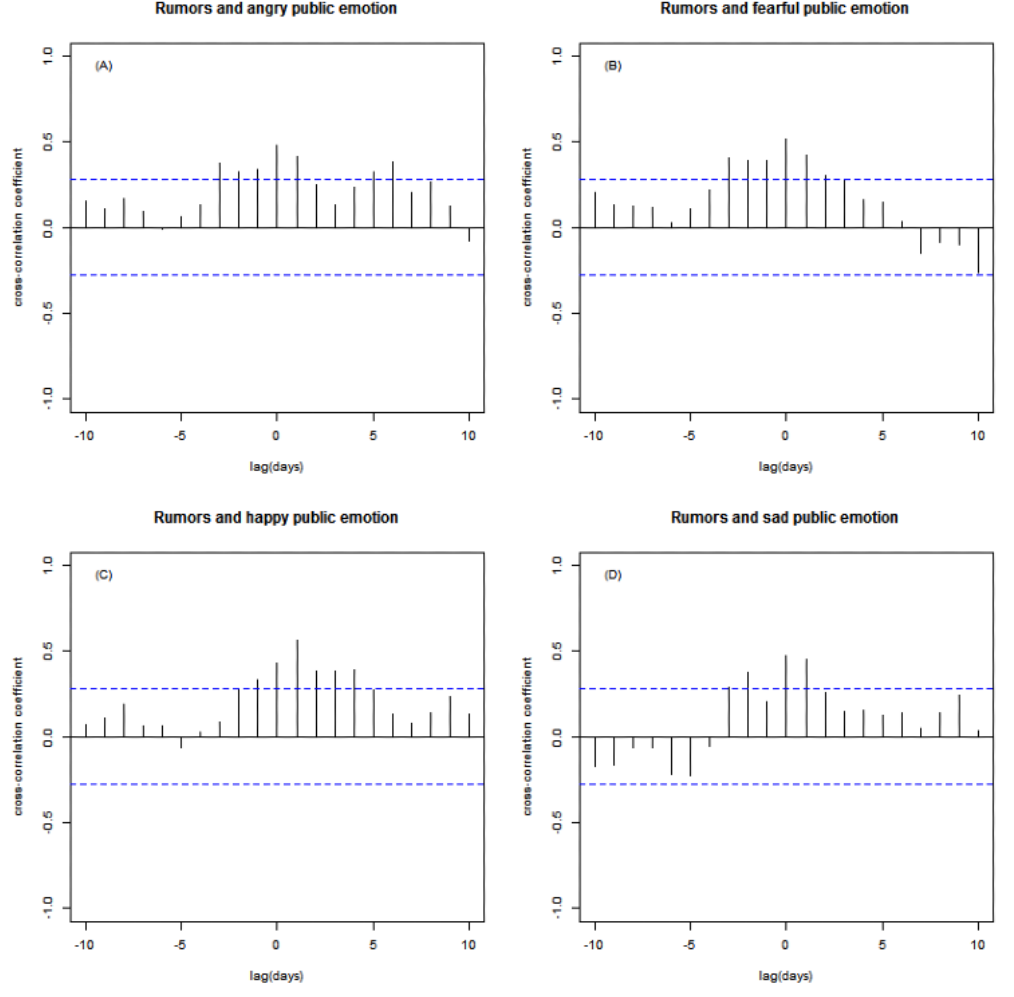
Figure 4. Cross-correlation between emotions and all rumors. Cross-correlation between (A) anger and all rumors, (B) fear and all rumors, (C) happiness and all rumors, and (D) sadness and all rumors. Blue dashed lines denote the 95% confidence intervals of the uncorrelated time